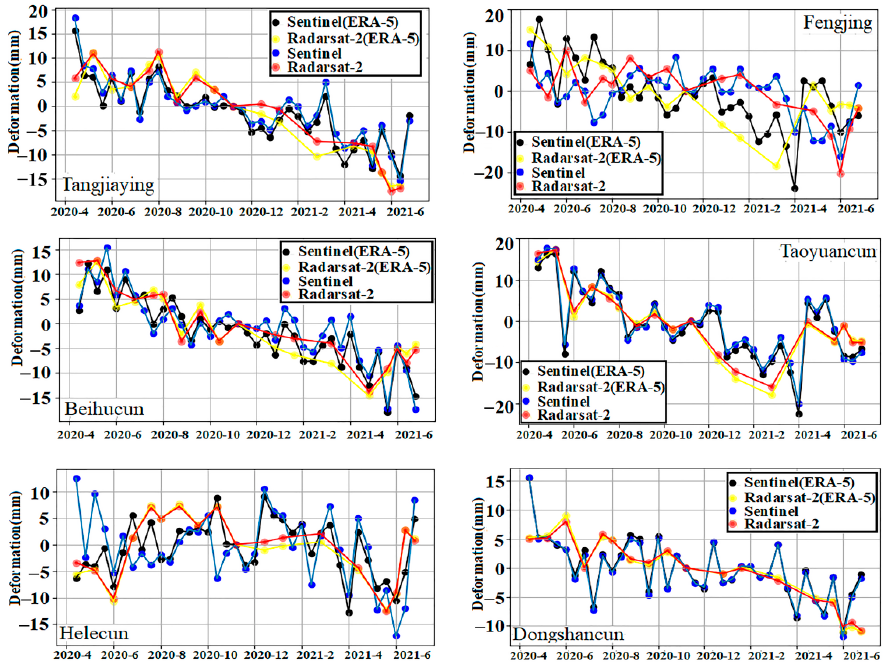
Figure 10. PS point time-series displacement (the exact locations of the six villages are marked with purple circles in Figure 9.